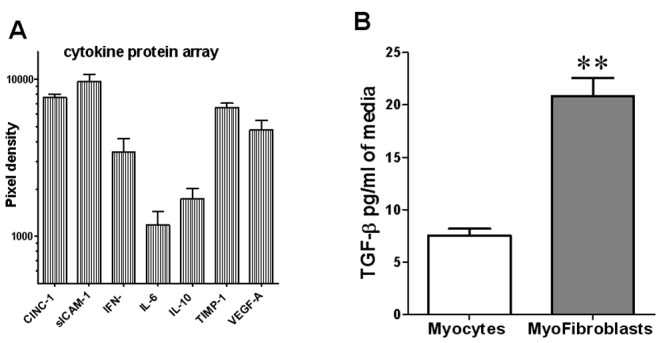
Protein analyses of cytokine expression in fibroblast conditioned media.3A) Protein analyses of cytokine expression in fibroblast conditioned media by cytokine array. Values are mean ± standard error of the mean, N = 3 in each group. 3B). Concentration of TGF-β1 in rat myocyte conditioned medium (black) and FCM (white) determined using a rat TGF-β1 ELISA kit (R&D Systems). Values are mean ± standard error of the mean, N = 3 in each group, **indicates p<0.01 significant difference between myocyte and FCM levels.